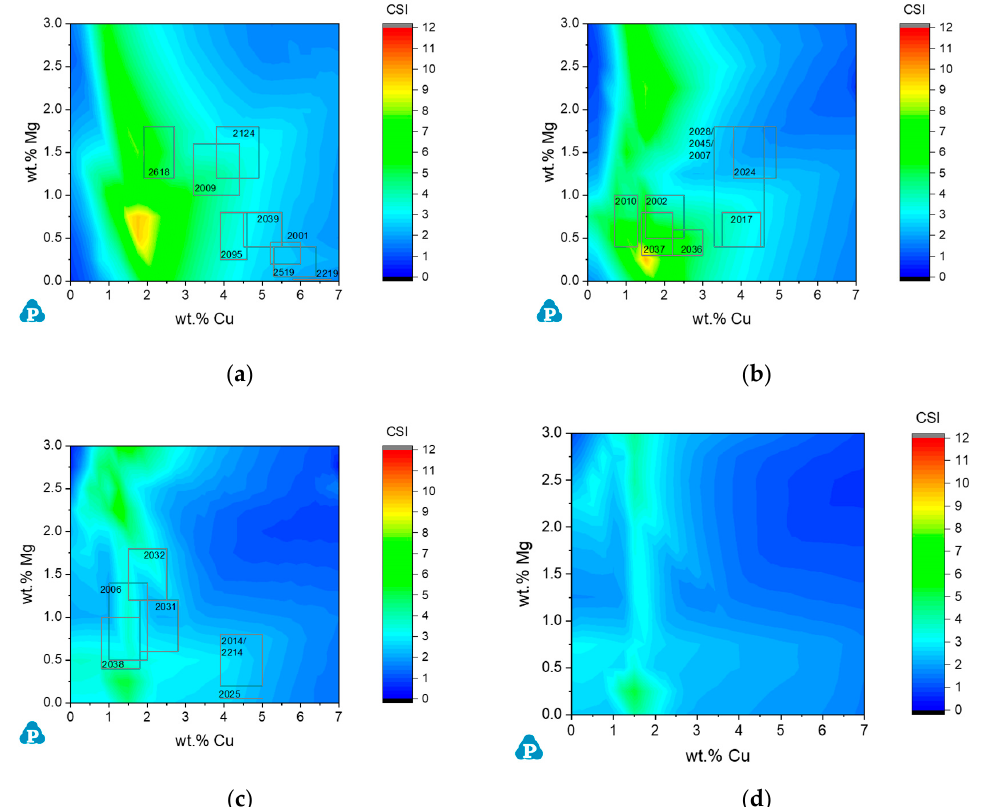
Figure 2. Calculated cracking susceptibility index (CSI) maps for AA2xxx alloys: ( a ) Al-0.6Fe-0.5Mn -0.2Si -xCu-yMg alloys; ( b ) Al-0.6Fe-0.5Mn -0.6Si -xCu-yMg alloys; ( c ) Al-0.6Fe-0.5Mn -1.2Si -xCu-yMg alloys; ( d ) Al-1.2Si-xCu-yMg alloys. Simulation is performed by improved Scheil model considering back diffusion in the solid under the cooling rate of 20 °C/s.